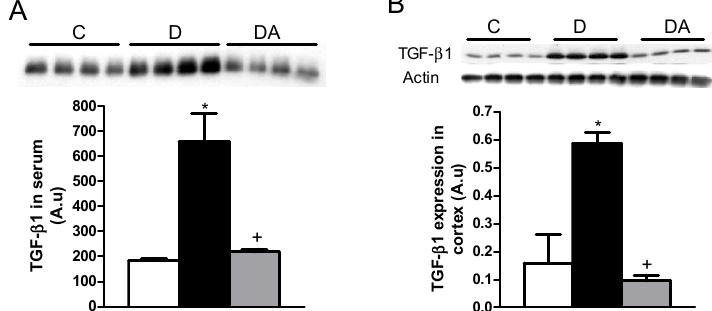
Figure 6. Effects of allicin on transforming growth factor beta (TGF- β 1) in plasma ( A ) and kidney cortex ( B ). C, D and DA in figures represent the control, untreated diabetic and allicin-treated diabetic groups, respectively. Data represent the average of all the animals ( n = 6) in a given group ± SEM (* p < 0.05 vs. the control group; + p < 0.05 vs. the diabetic groups).